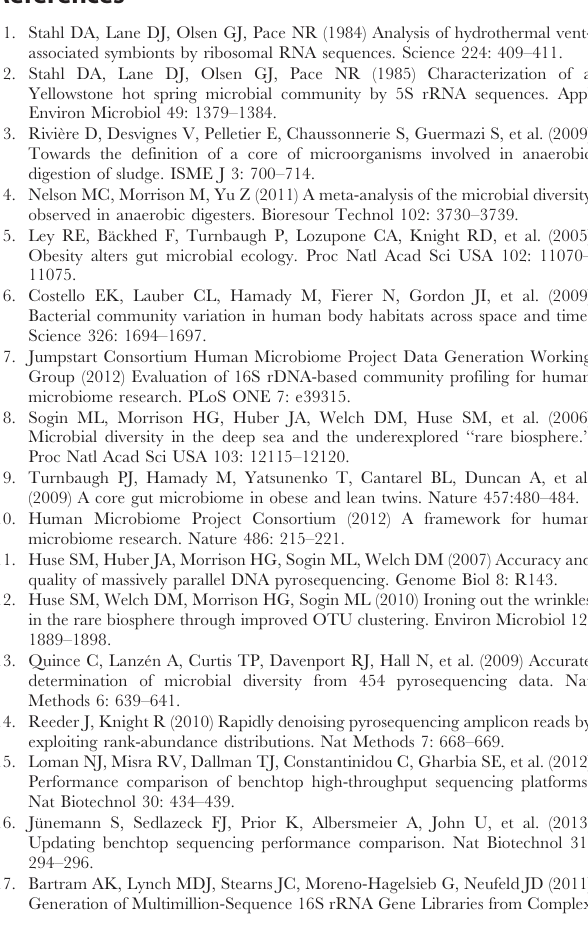
Figure S1 Effects of processing method on PCoA analysis using the Bray-Curtis metric.